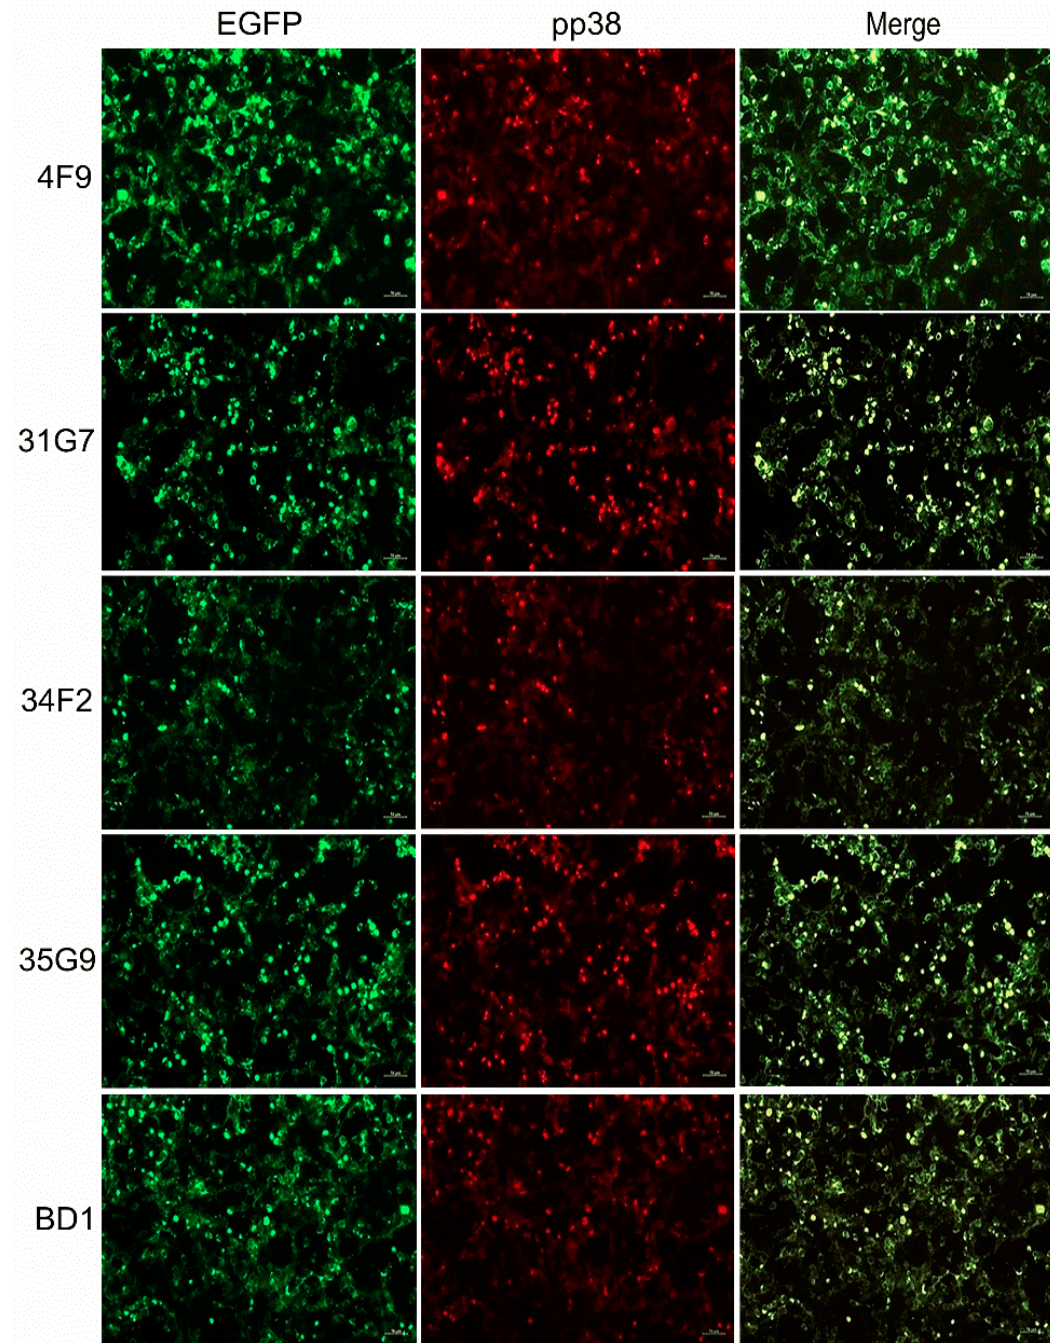
Figure 4. Staining of pp38 proteins overexpressed in 293T cells by immunofluorescence assay. The pp38 mAb BD1 served as a positive control. EGFP, enhanced green fluorescent protein with auto-fluorescence in green; pp38, MDV-1 phosphoprotein 38 stained in red; Merge, fused image in yellow. Scale bar = 50 µm.